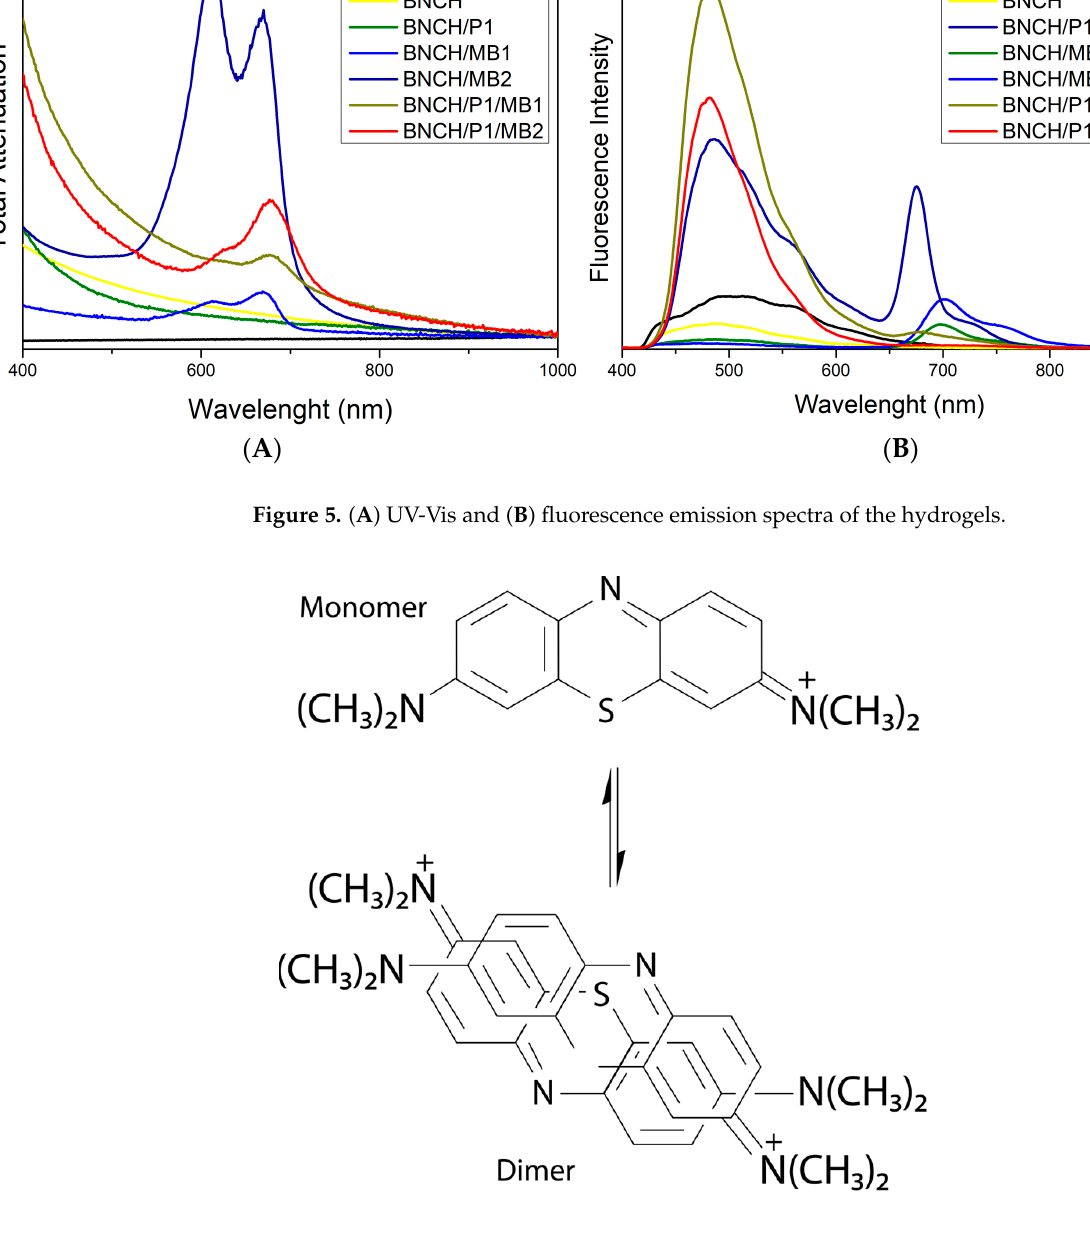
Figure 6. Chemical structure of methylene blue and its possible dimer. The BNC/propolis hydrogel also does not present absorption bands in this region of the spectrum. Some previous studies on the ethanolic extract of propolis have reported maximum absorbance around 295 nm, as well as absorption of phenolic compounds under UV light [70,75]. However, this wavelength was not addressed in this work since the PDI application uses visible light, in this case at 660 nm due to the MB maximum absorbance. In the fluorescence spectra of the formulations (Figure 5B), there are two main emis- sion bands: one between 450 nm and 550 nm and another between 650 nm and 750 nm, corresponding to blue/green and red regions, respectively. Except for BNCH/MB1 and BNCH/MB2, all samples present an emission band around 500 nm. Only hydrogels con- taining MB have a band at 700 nm, suggesting the emission of the dye, which, in its pure state, emits fluorescence at 680 nm